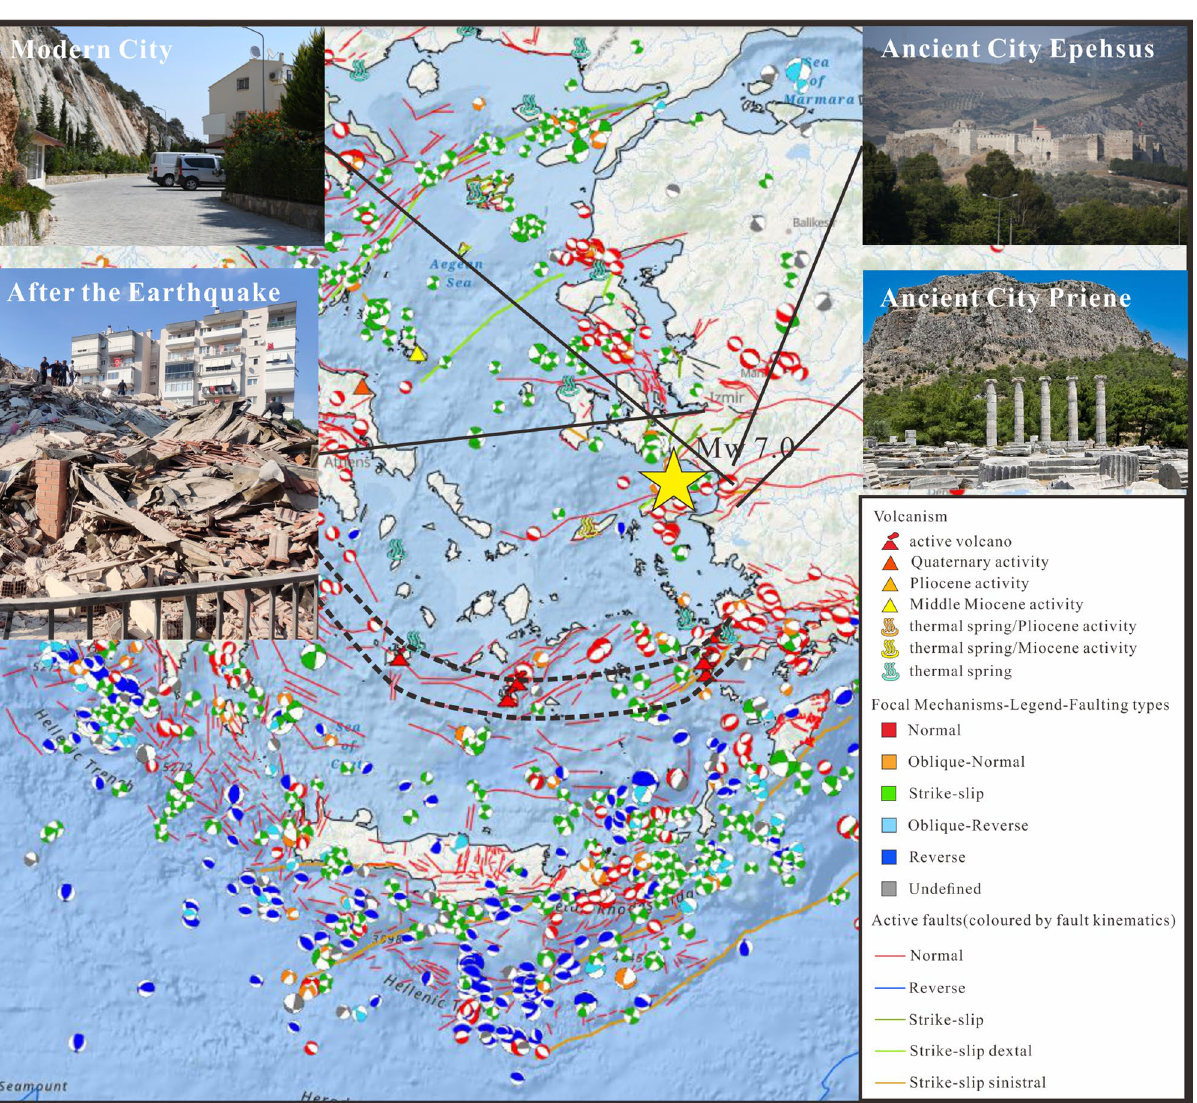
Figure 4. Snapshot from the online GIS platform New Seismotectonic Atlas of Greece v1.0 56,57 , presenting focal mechanisms (period 1995–June 2020, by SL-NKUA) and active faults 58 , colored by fault type, along with volcanism and hydrothermal activity. The epicenter of the October 30th 2020 main shock is presented by a yellow star. Black dash lines preset the Aegean Volcanic Arc. The inset photos shows the ancient and modern cities which suffered destructive earthquakes, note that they are all built close to active faults. The interactive GIS web application of the New Seismotectonic Atlas of Greece v1.0 is available at the following link: http:// www. geoph ysics. geol. uoa. gr/ atlas.